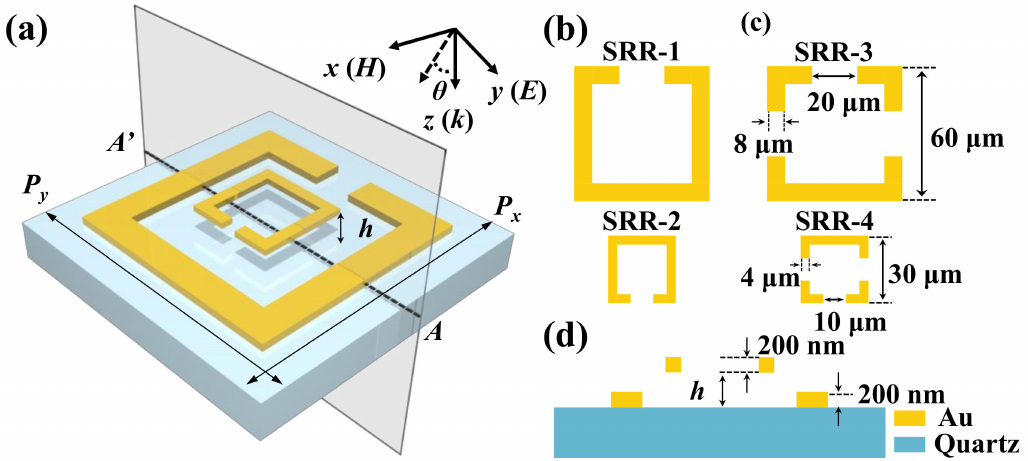
Figure 1. ( a ) Schematic drawing of TTM-1; ( b ) and ( c ) top-views of SRR-1 to SRR-4 and the corresponding geometrical parameters; ( d ) cross-sectional view of TTM-1 along AA’ line in ( a